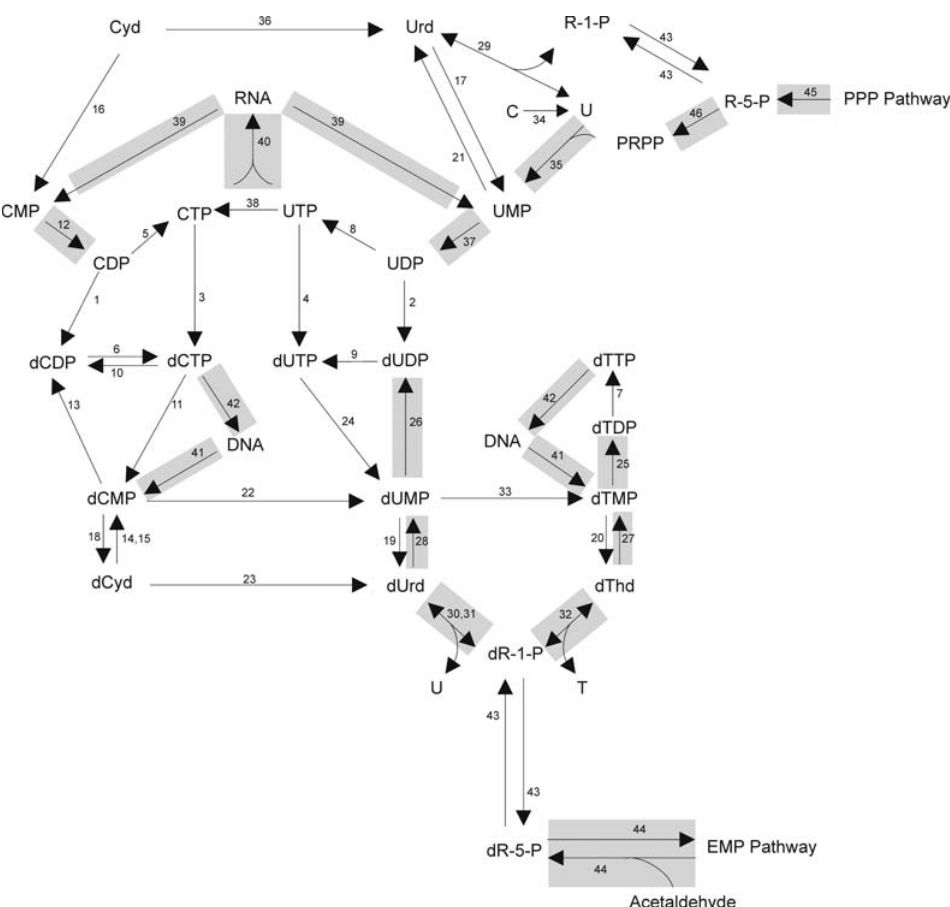
Figure 2 -Schematic representation of pyrimidine nucleotide metabolic pathways found or suggested to be present in Mollicutes. The reaction pathways added in this representation were experimentally reported and/or a gene coding the putative corresponding enzyme was annotated in at least one of the 12 genome-sequenced mollicutes analyzed in this work. For reactions shown in gray we have found the corresponding CDS in all mollicutes except Onion Yellow Phytoplasma (for some of these CDSs an orthologue was also identified in this Phytoplasma). Enzyme activities: 1, ribonucleoside-diphosphate reductase - CDP reductase; 2, ribonucleoside-diphosphate reductase - UDP reductase; 3, ribonucleoside-triphosphate reductase (RTR) - CTP reductase; 4, ribonucleoside-triphosphate reductase (RTR) - UTP reductase; 5, CDP kinase; 6, dCDP kinase; 7, dTDP kinase; 8, UDP kinase; 9, dUDP kinase;